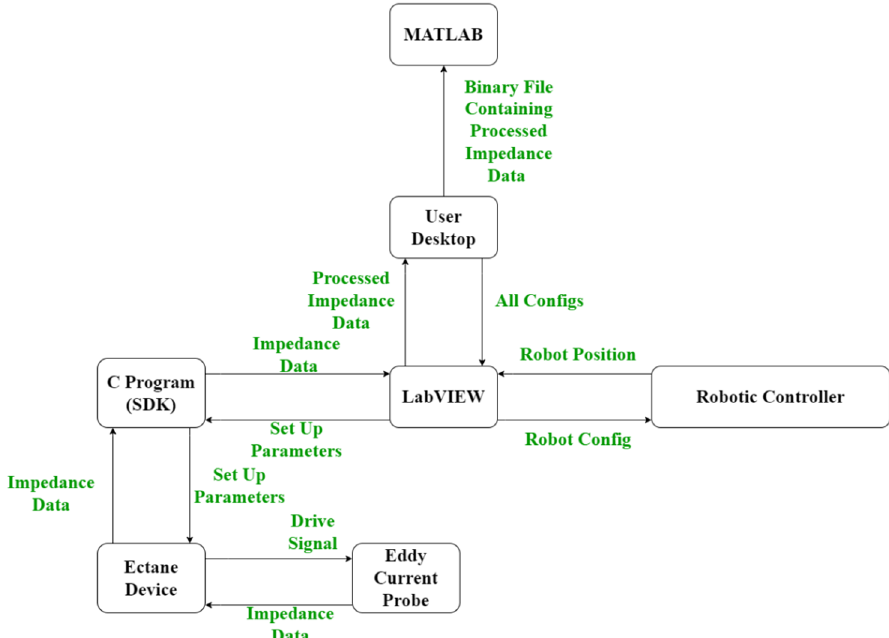
Figure 5. A flow chart showing the data transfer between different software and hardware elements. In total 3 programs were developed: (1) A C program that houses the Eddyfi Ectane 2 SDK; (2) A LabVIEW program that receives, post-processes and plots impedance data in real-time as well as saving the data in a binary file format; and (3) A MATLAB reviewer program that reads in the binary file for further